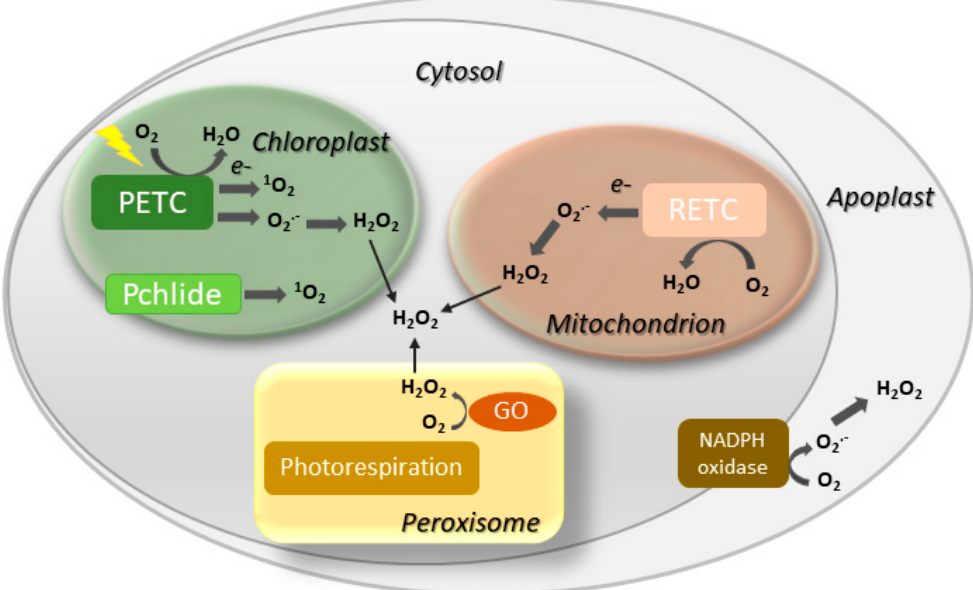
Figure 2. Major sites of ROS generation in the plant cell. GO, glycolate oxidase; Pchlide, protochlorophyllide; PETC, photosynthetic electron transport chain; RETC, respiratory electron transport chain. Disproportionation of O 2. − into H 2 O 2 may be spontaneous or mediated by a suite of superoxide dismutases.